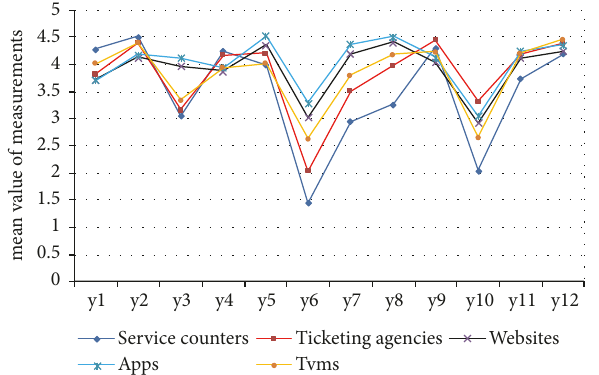
Figure 3: Indicators scores of the three latent